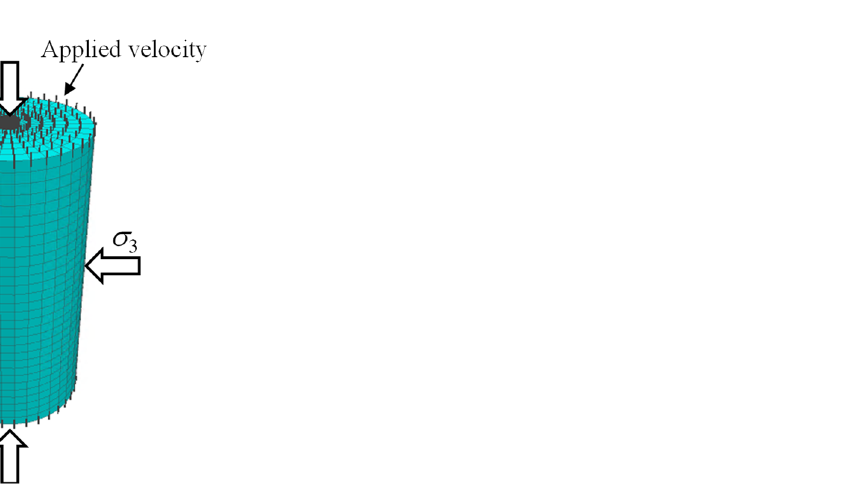
Figure 8. A numerical model of consolidated drained triaxial compression tests built with FLAC 3D . In the simulations, the Poisson’s ratio is related to the friction angle of backfill considering a unique value of the at-rest earth pressure coefficient K 0 . The ratio of tensile strength T to UCS of backfill is taken as 0.41 according to the experimental results of Rankine [28]. e ini is calculated as 1.05 based on the measured porosity. Calibrations based on the laboratory results under confining pressures of 100 and 200 kPa are performed to obtain some unknown parameters involving c and φ , K and G for the Mohr–Coulomb model, R and the piecewise-linear function of p c for the double-yield model, λ *, κ *, and p c for the Soft Soil model. Table 2 shows material parameters used for numerical simulations. The calibrated numerical models are then applied to predict the laboratory results of Rankine [28] under a confining pressure of 500 kPa. Table 2. Parameters of different constitutive models applied for backfill in numerical simulations of the consolidated drained triaxial compression tests with ρ = 2091 kg/m 3 . Constitutive